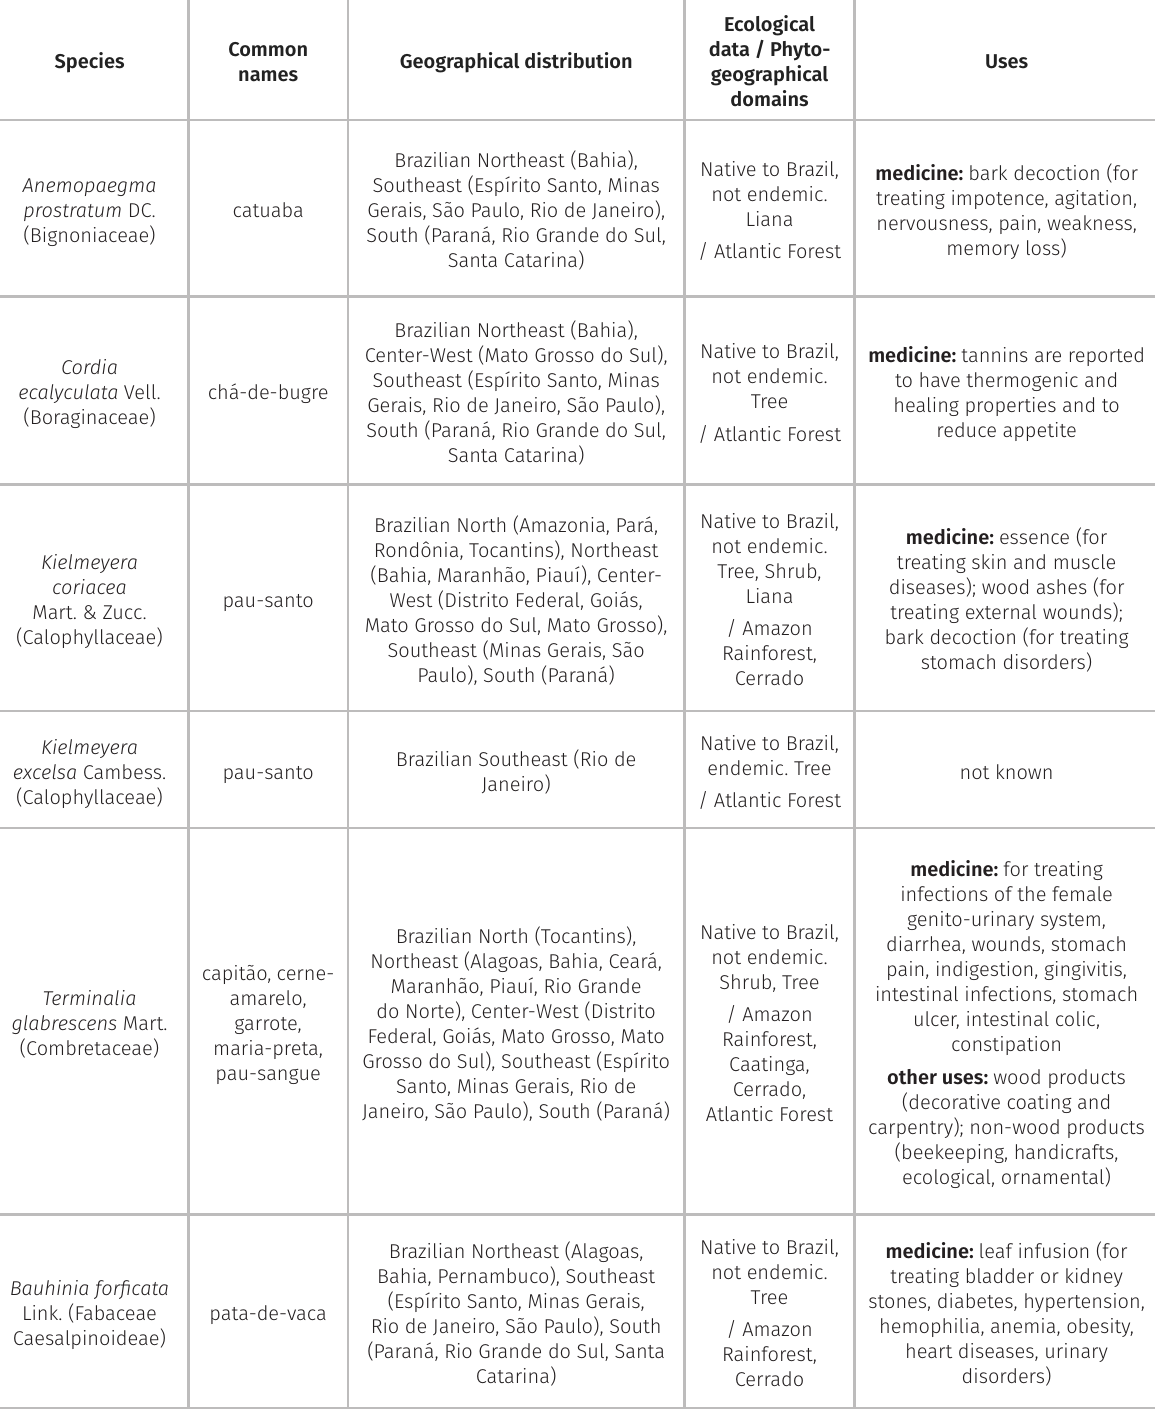
Table I. Supplementary data for the studied species (common names, geographical distribution, ecological data, phytogeographical domains,